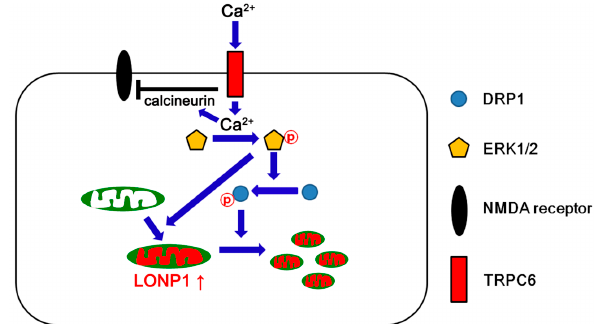
Figure 6. Scheme of roles of TRPC6 in LONP1 expression and mitochondrial dynamics based on the present data and previous reports [11,15,16,20,30]. TRPC6 activation increases Ca 2 + influx in DGC. Intracellular Ca 2 + activates calcineurin and ERK1 / 2. Activated calcineurin inhibits the NMDA receptor. In addition, ERK1 / 2 activation up-regulates LONP1 expression and DRP1 phosphorylation at the 616 site. Subsequently, phosphorylated DRP1 facilitates mitochondrial fission. Thus, TRPC6 may be involved in the quality controls of mitochondria as well as mitochondrial dynamics, which would enhance DGC invulnerability to SE.